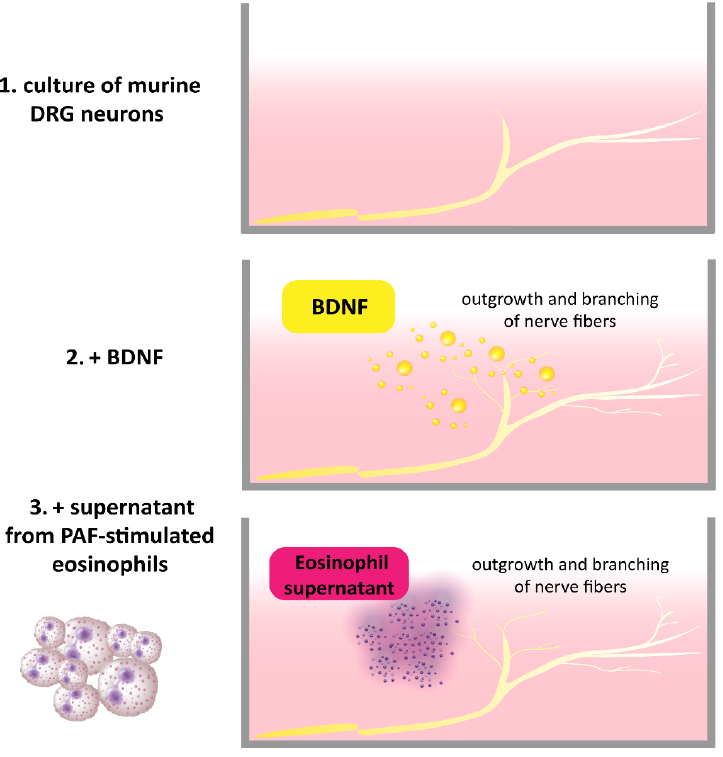
Figure 2. BDNF released by PAF ‐ stimulated AD eosinophils induces the outgrowth and branching of mouse DRG neurons [7]. mouse DRG neurons